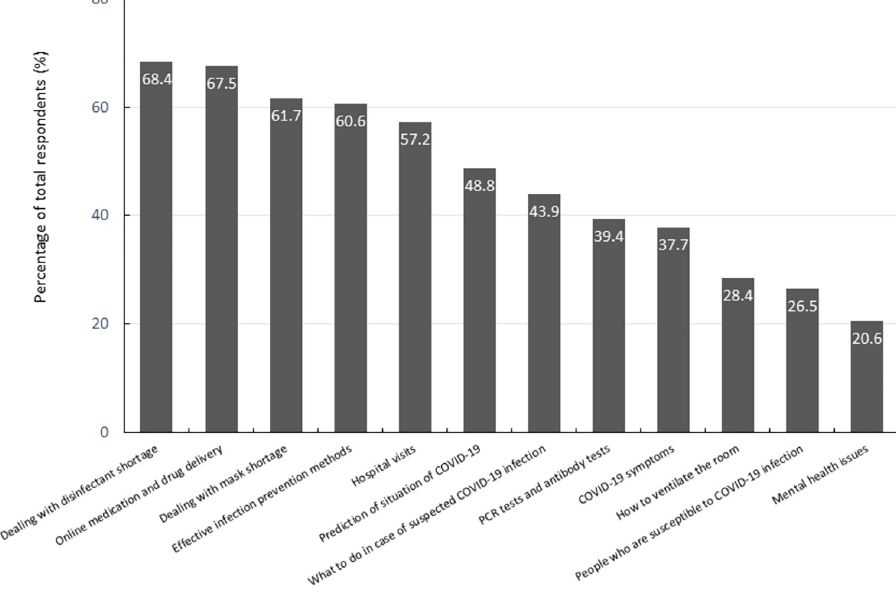
Fig 1. COVID-19-related topics discussed in pharmacists’ consultations with local residents. Multiple-response data were obtained on COVID-19-related consultations provided to local residents by pharmacists in health support